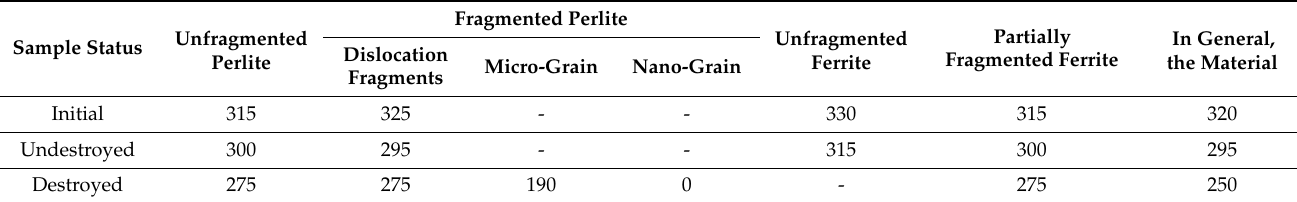
Table 4. Amplitude of shear stresses σ L in various morphological components of the fine structure and in the whole material